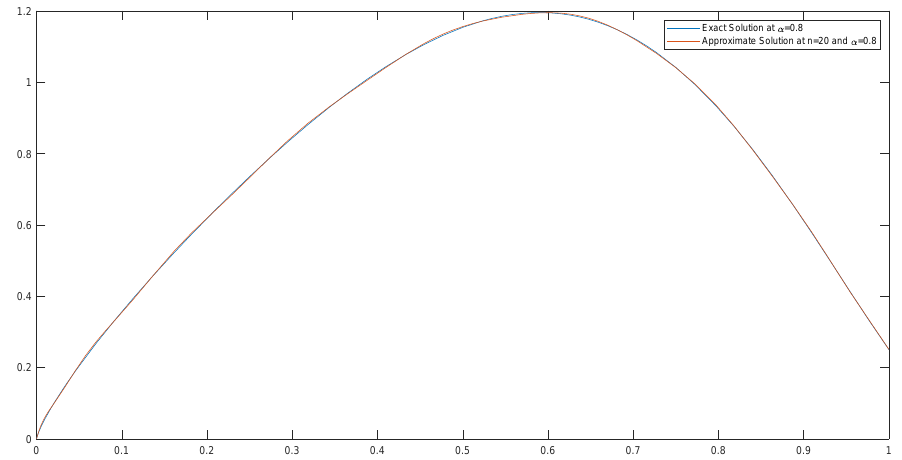
Figure 5. Exact and approximate solutions of Example 4 are compared at n =